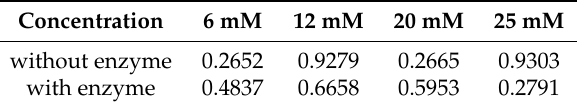
Table 9. Bartlett’s